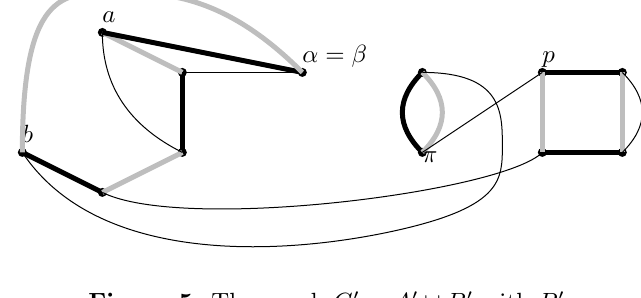
Figure 4 . G and P along with a (cid:12)rst edge for the construction of Q (dashed line).